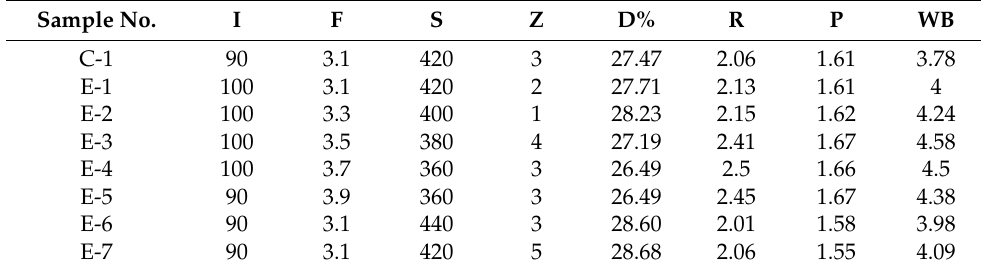
Table 8. Experimental runs outside the orthogonal